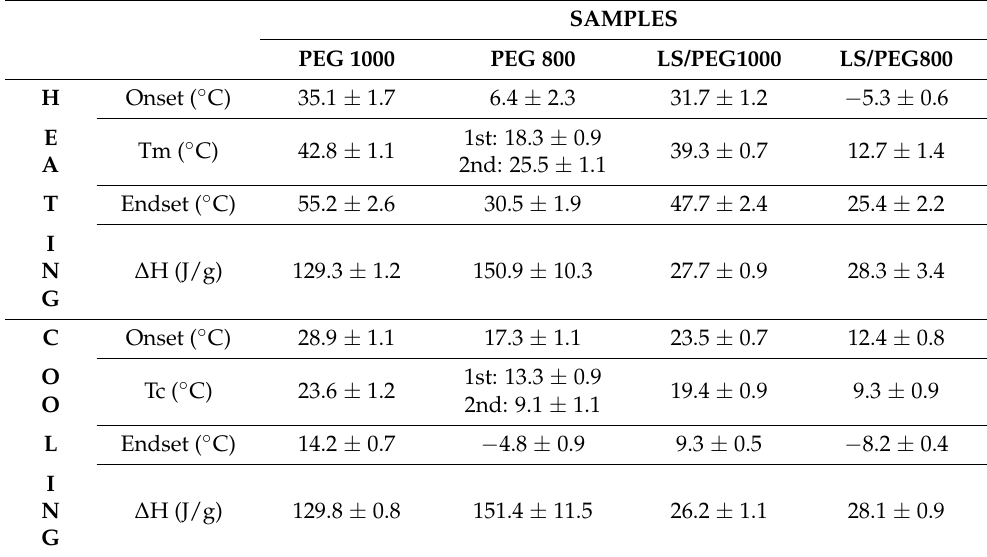
Figure 2. DSC curves recorded for ( a ) PEG 800 and PEG 1000 polymers; ( b ) LS/PEG800 and LS/PEG1000 composites. Table 3. LHTES properties measured in DSC on PEG 800, PEG 1000 and their PCM-stone composites, LS/PEG800 and LS/PEG1000: Onset and Endset, initial and final temperatures of the thermal process, respectively; Tm and Tc, peak temperatures of the melting and crystallization processes, respectively, recorded during heating/cooling stages; ∆ H, enthalpy measured during heating/cooling stages. DSC data of PEG 1000 and LS/PEG1000 have been measured in [31].